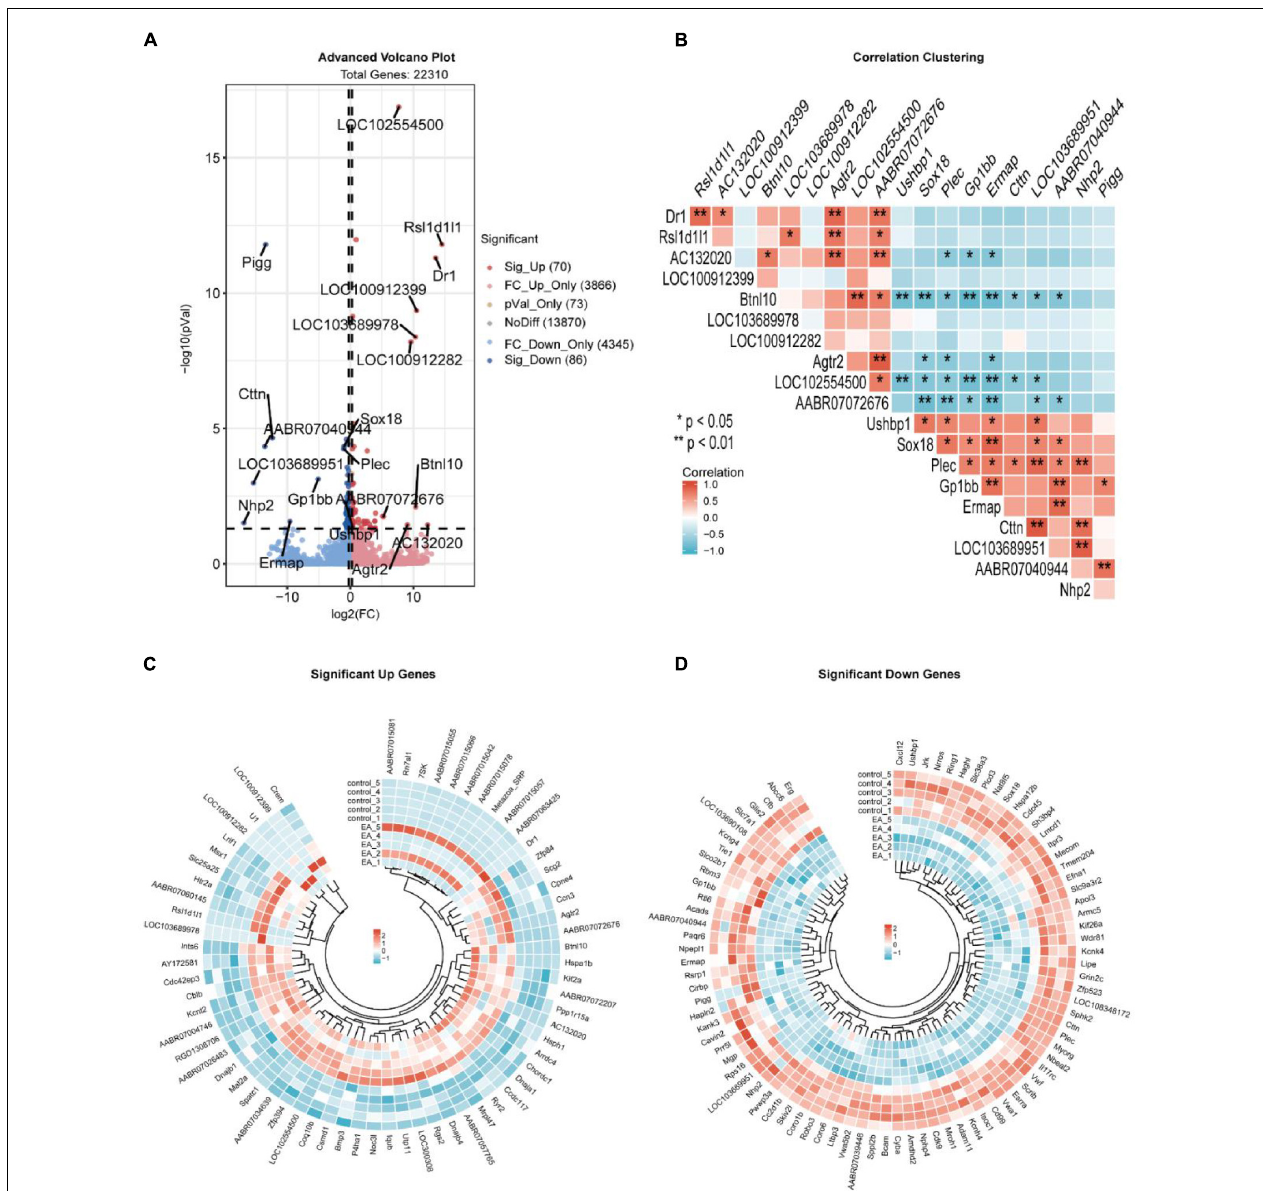
FIGURE 2 | Volcano plot of DEGs (A) , the correlation of the first 10 significantly up-regulated genes and significantly down-regulated genes (B) , the expression of up-regulated genes in electroacupuncture group and control group (C) , and the expression of down-regulated genes in electroacupuncture group and control group (D)